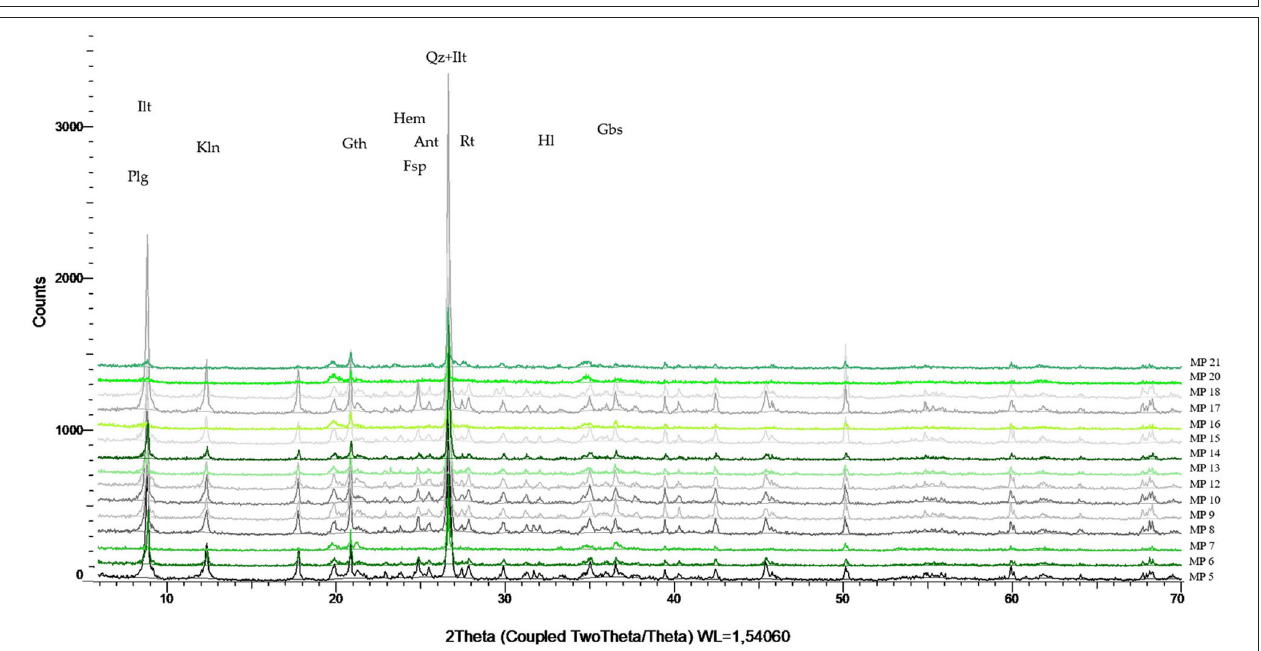
FIGURE 6 | XRPD patterns of representative MP palaeosol samples. Legend. See Figure 5 .